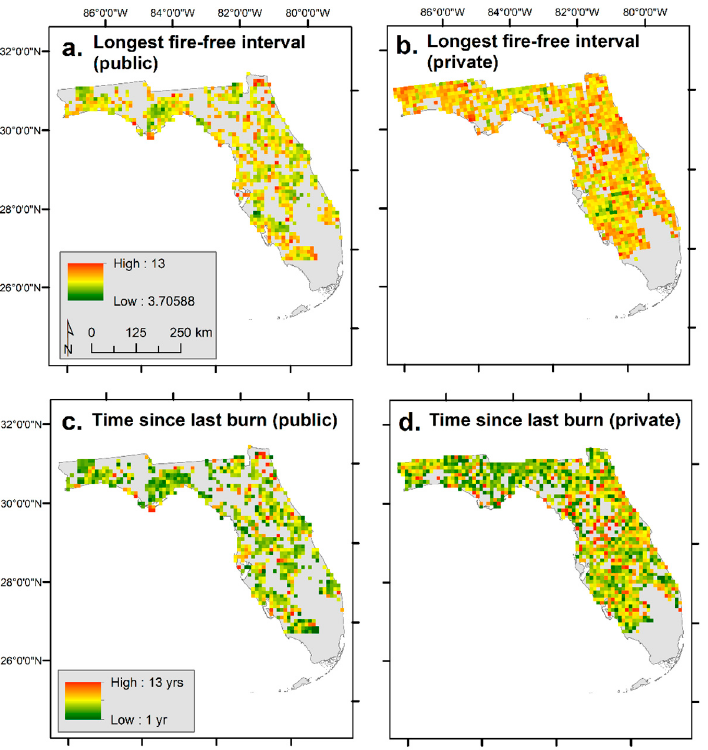
Figure 6. Fire history metrics for natural pinelands including ( a ) the longest fire-free interval (LFFI) on public land, ( b ) the LFFI on private land, ( c ) time since last burn (TSLB) on public land, and ( d ) TSLB on private land. Units in years. The 30 m resolution LFFI values were averaged within 10 km grid cells to improve visibility. Legends are identical for a and b and for c and d .